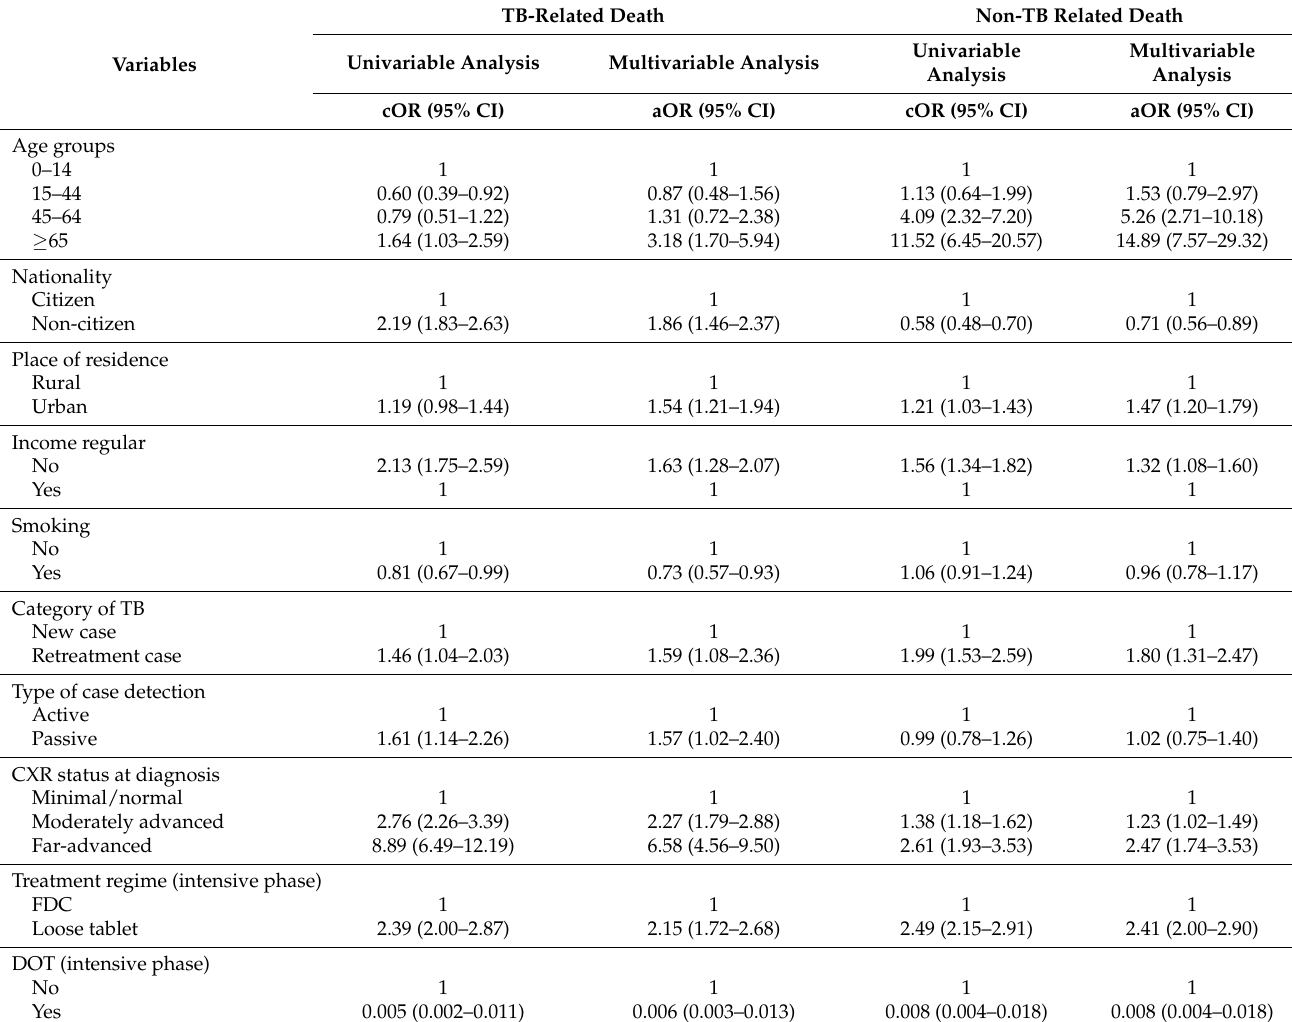
Table 6. Multinominal logistic regression analysis for association between sociodemographic, disease, and treatment characteristics with TB-related and non-TB-related